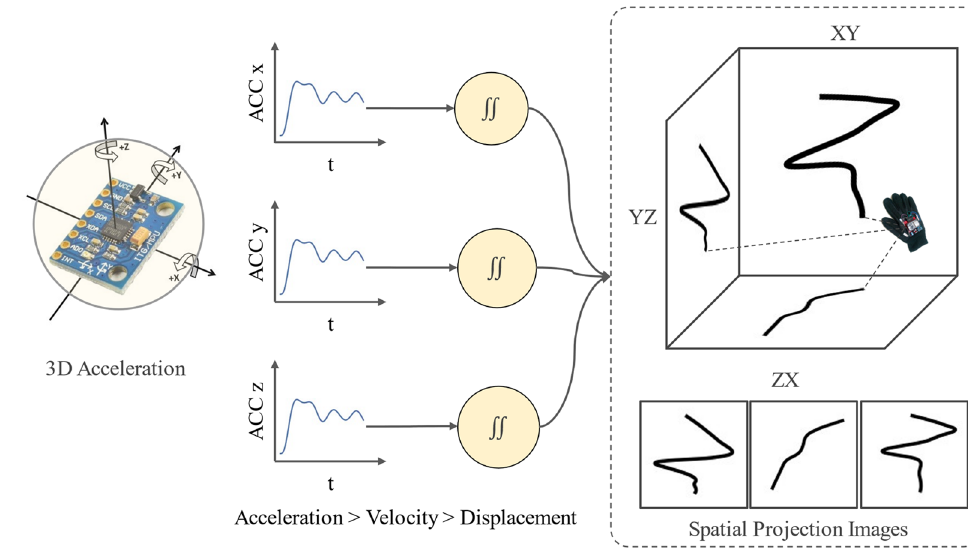
Figure 4. Spatial projection generation process. We start with the 3-axis acceleration and then convert them into 3-axis displacement vectors. These vectors are projected onto the 2D spatial planes to generate the projection